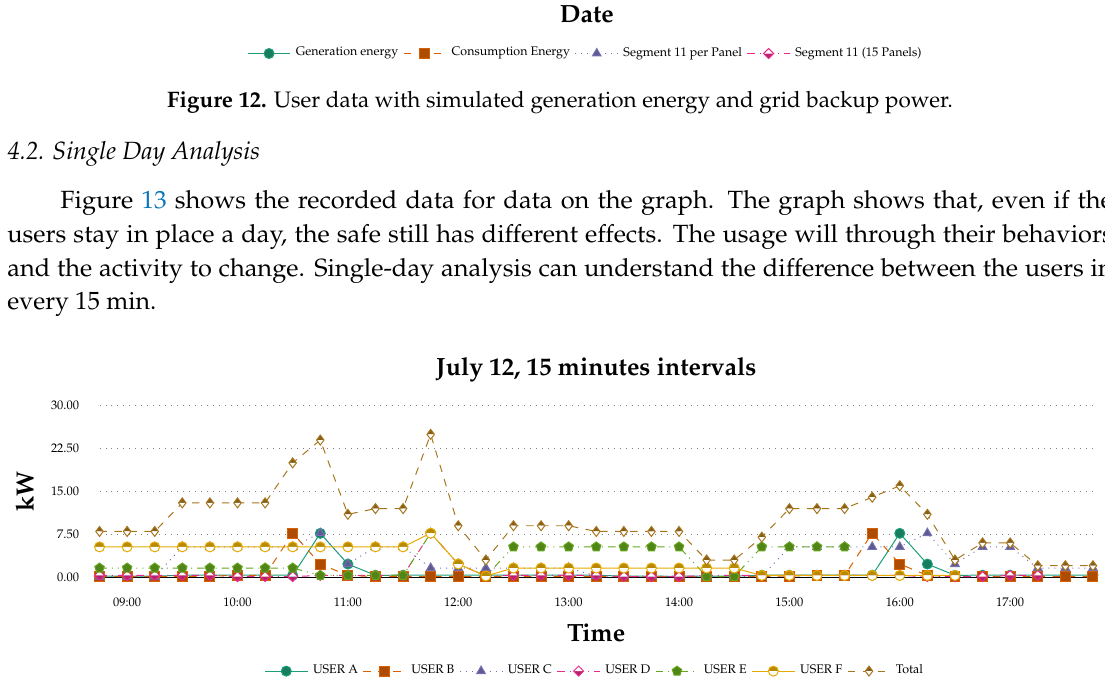
Figure 13. 12 July Scenario: Comparison of 15 min consumption energy of the six